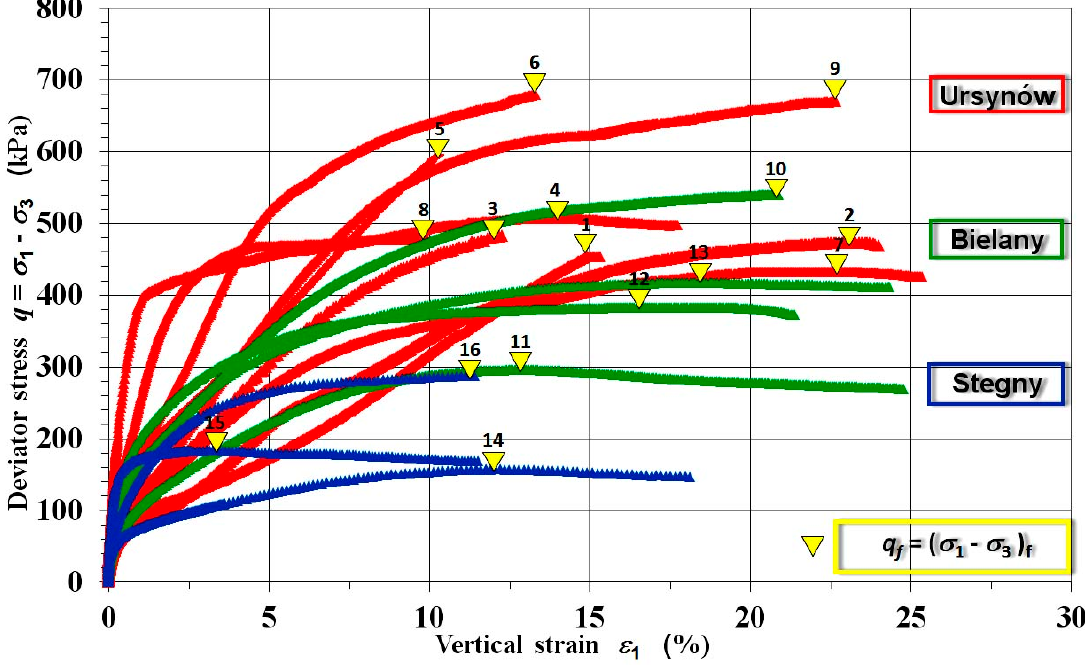
Figure 7. Characteristics of the deviator stress q depending on the vertical strain ε 1 from CIU triaxial tests for sixteen tested cohesive soils.